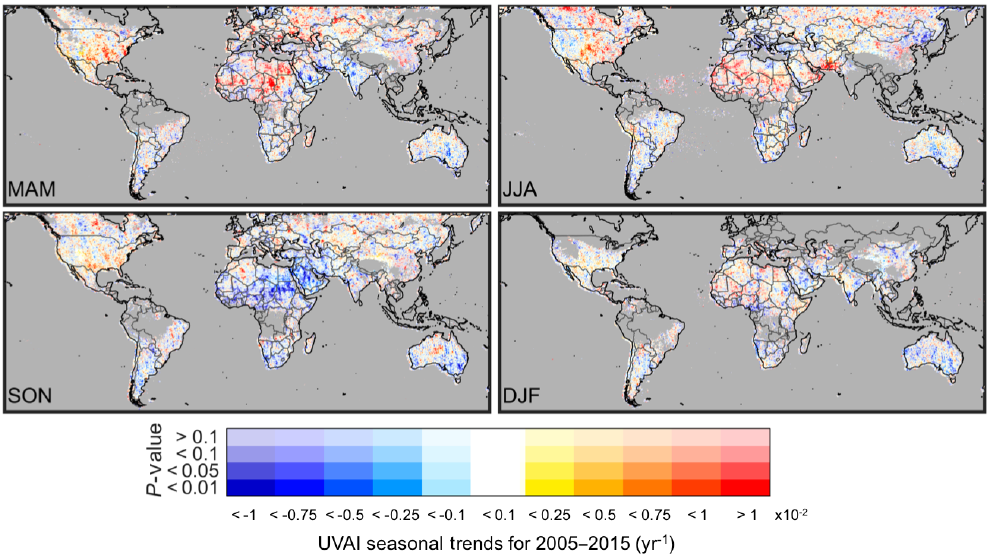
Figure 6. Seasonality of the trends in simulated UVAI values coincidently sampled from OMI calculated from the generalized least squares regression of monthly time series values during 2005–2015 for MAM (May, April, March), JJA (June, July August), SON (September, October, November), and DJF (December, January, February). The opacity of the colours indicates the statistical significance of the trend. Grey indicates persistent cloud fraction greater than